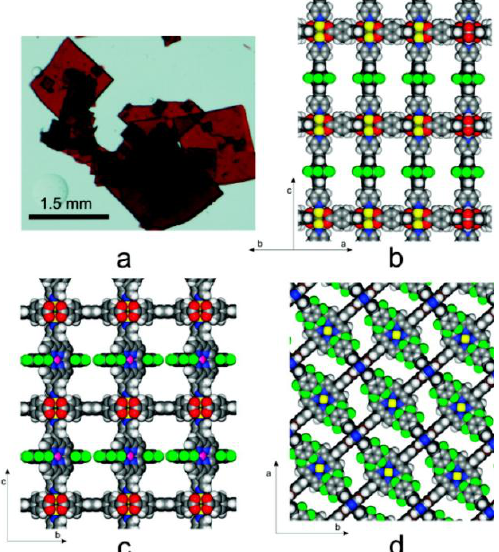
Figure 3. ( a ) Optical photograph of ZnMn-RPM crystals. ( b – d ) Schematic representations of the crystal structure features of ZnMn-RPM showing channels in the three crystallographic directions (Colour scheme: yellow = Zn, red = O, green = F, blue = N, gray = C, white = H, purple = Mn). Disordered solvent molecules have been omitted for clarity. Reprinted (adapted) with permission from [24]. Copyright (2011) American Chemical Society.